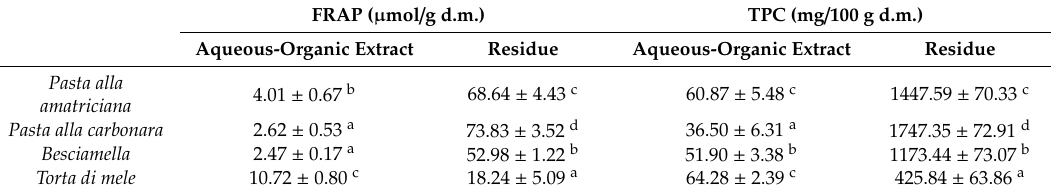
Table 1. Ferric Reducing Antioxidant Power (FRAP) and Total Polyphenol Content (TPC) of popular Italian dishes